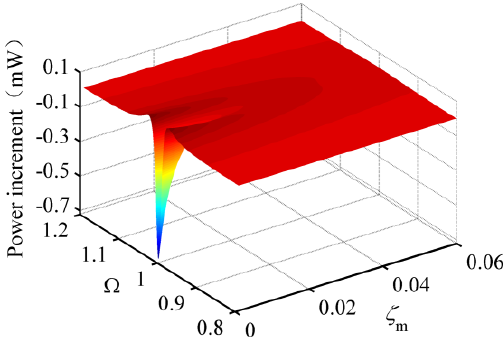
Figure 7. The output power increment of the HEH relative to the conventional PEH with matched load resistances for different Ω and ζ m .